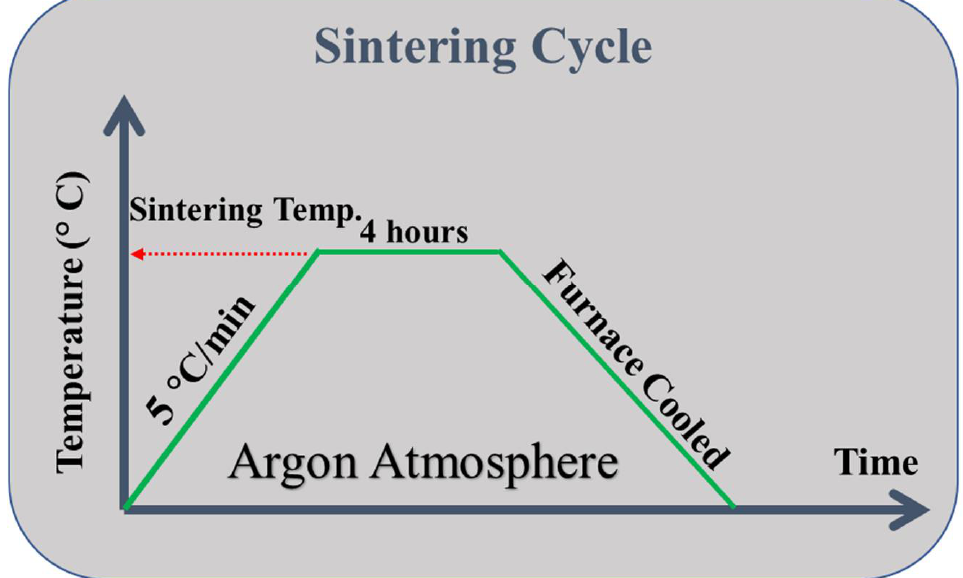
Figure 3. Sintering cycle describing the sintering of membranes at a rate of 5 °C/min for 4 h in an argon atmosphere at two separate temperatures of 800 °C and 900 °C.